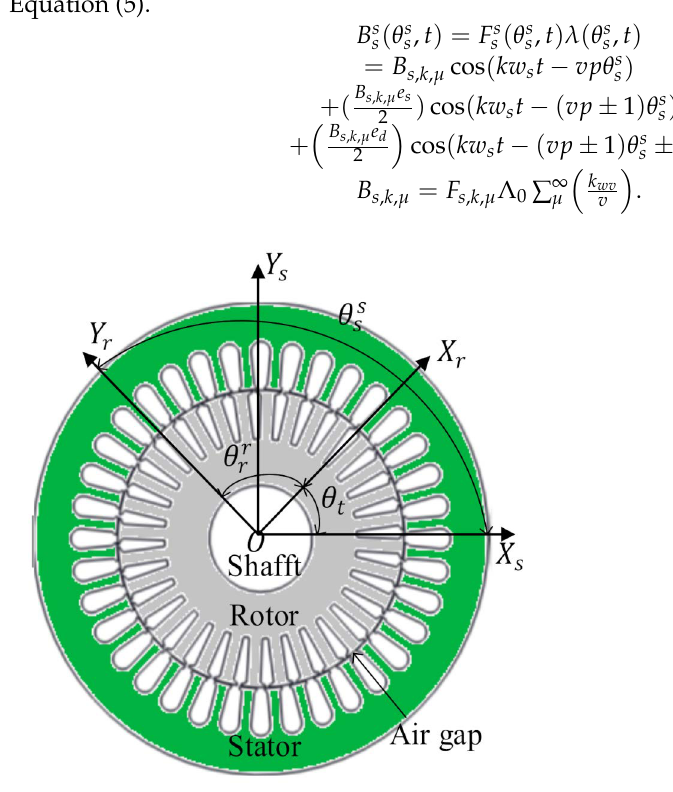
Figure 4. Coordinate system